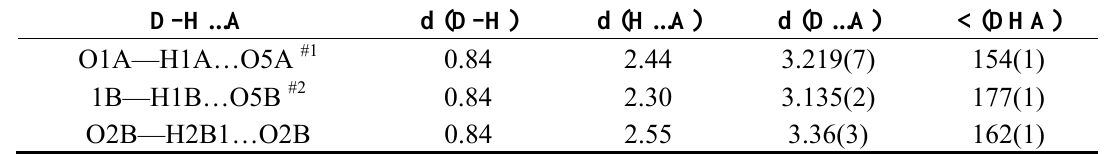
H O , [Å and 26 25 5